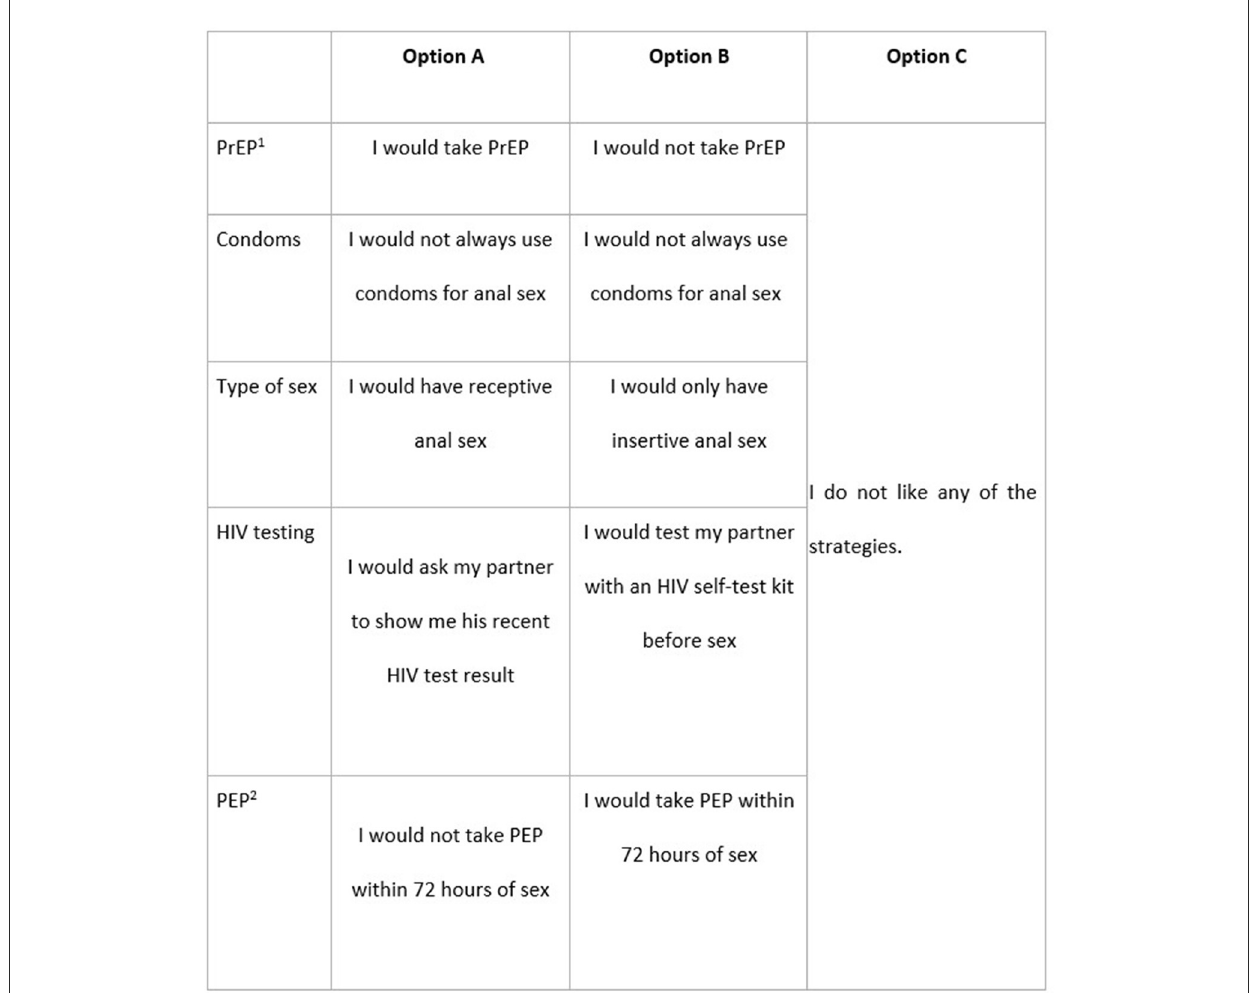
FIGURE1 Example choice set. Imagine you are going to have sex with someone where you are not completely certain he is HIV-negative. What strategy would you prefer to protect yourself against HIV? 1 PrEP, Pre-exposure prophylaxis; 2 PEP, Post-exposure prophylaxis.